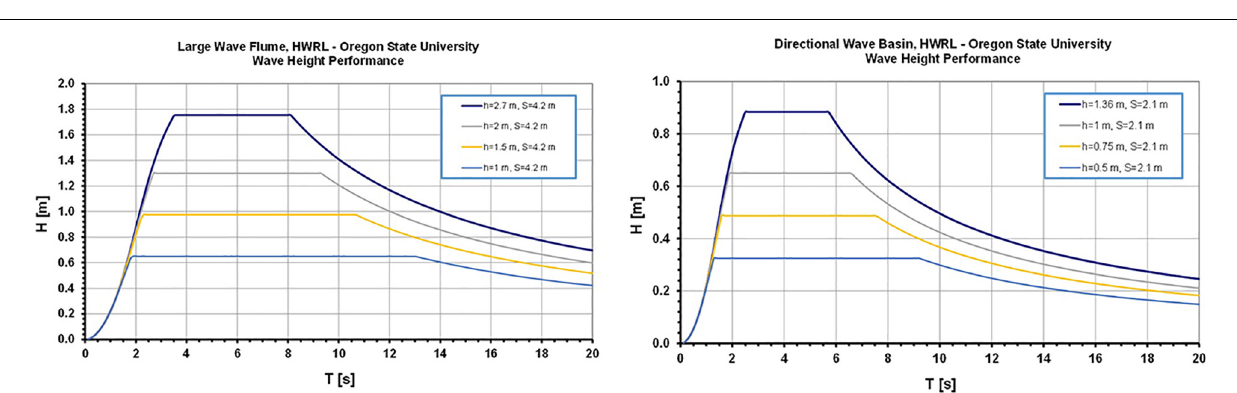
FIGURE 3 | Wavemaker performance for LWF (left) and DWB (right)